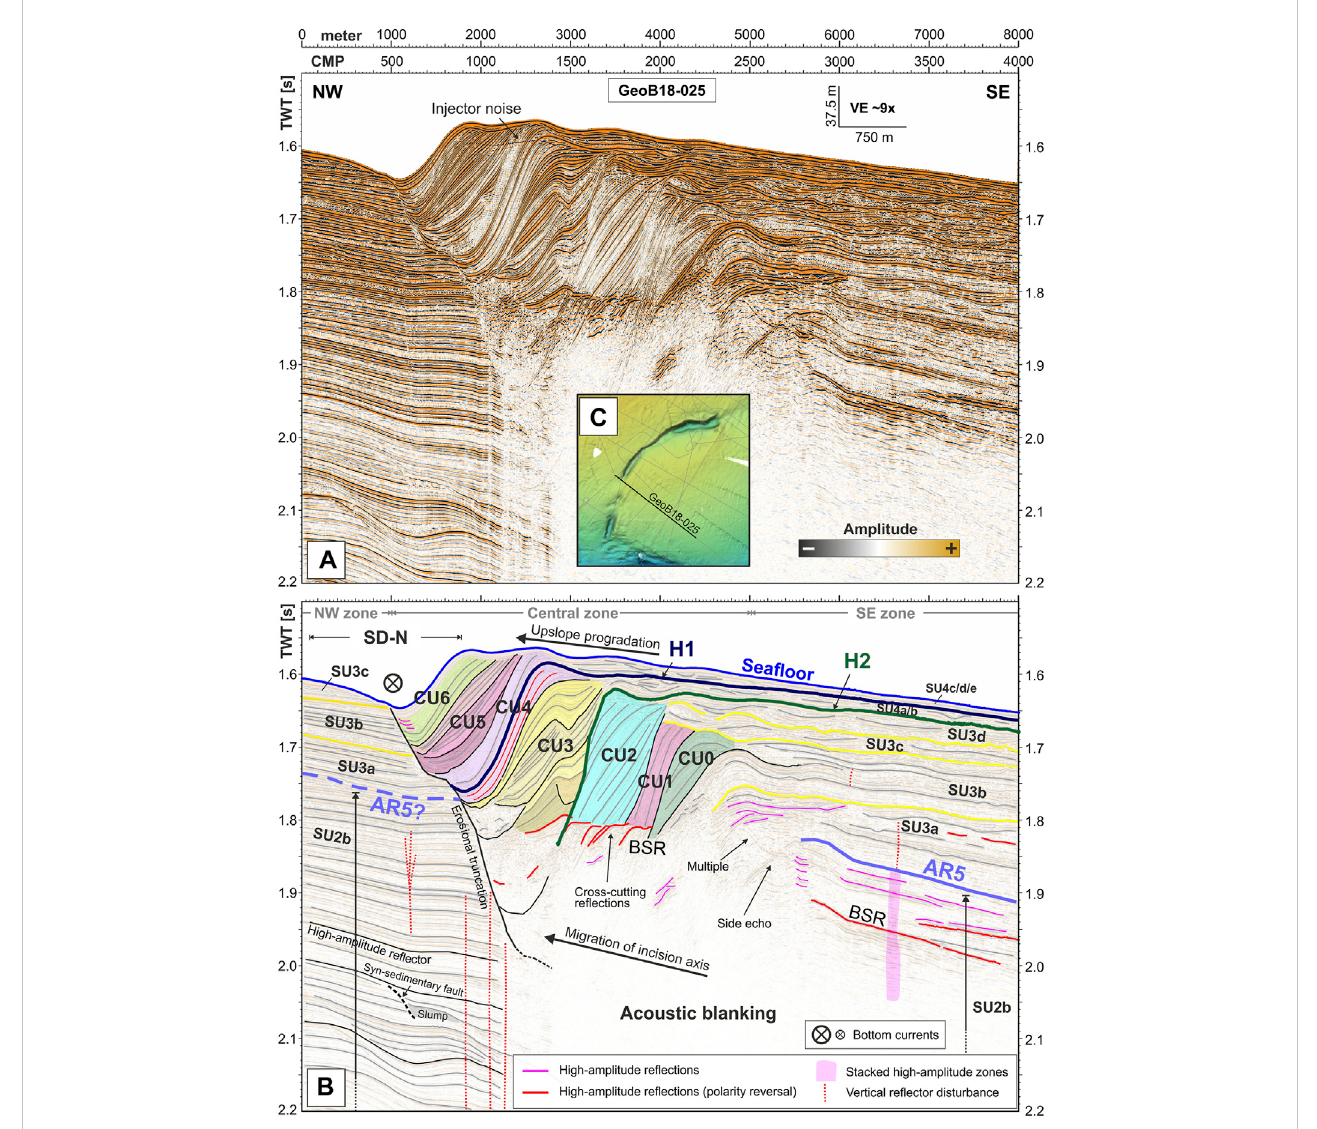
FIGURE 7 Seismic pro fi le GeoB18-025 as (A) migrated section and (B) interpreted line drawing showing a complex clinoform re fl ection pattern featuring seven main and several secondary clinoform units(CU). Interpretations of stratigraphichorizons H1, H2, and AR5 and seismic units (SU3a-d) are based on Preu et al. (2012) (cf. Section 2.3). Different amplitude anomalies like high amplitude patterns, re fl ections with reversed sea fl oor polarity, and narrow vertical zones of disturbed re fl ections indicate the presence of gas and potential fl uid migration. Signi fi cant pro fi le parts below 2 s TWT and seaward of SD-N are masked by acoustic blanking. (C) Bathymetry map showing pro fi le